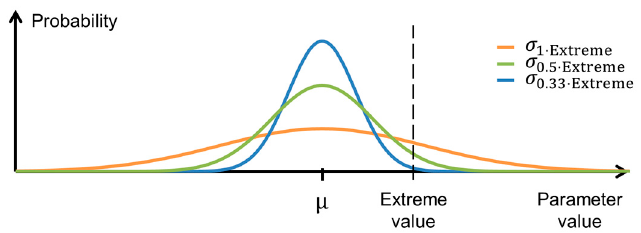
Figure 4. Visualisation of the connection between extreme parameter values and applied standard deviations.